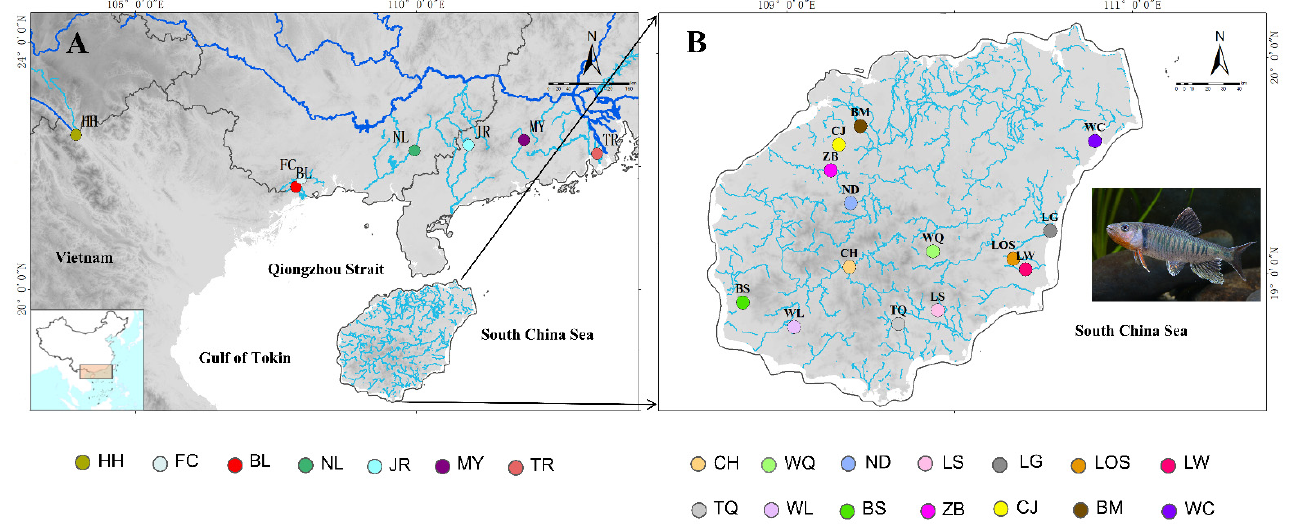
Figure 1. Maps of the study region in mainland China ( A ) and Hainan Island ( B ) indicate sites where 21 sampling localities of O. hainanensis were collected (circles). Sampling locations for the geotechnical sites were presented in the text and Table